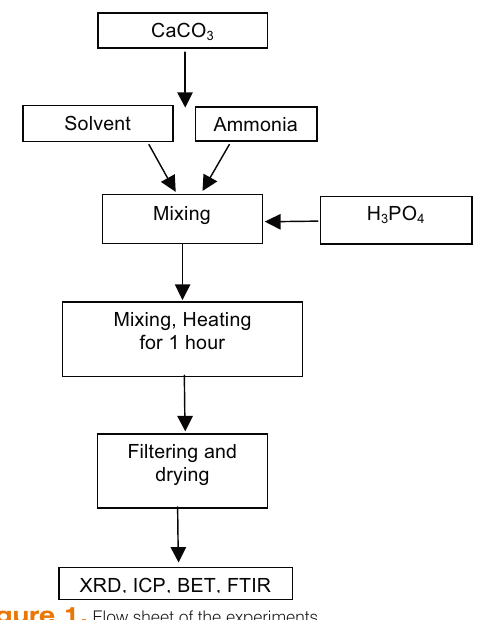
Figure 1. Flow sheet of the